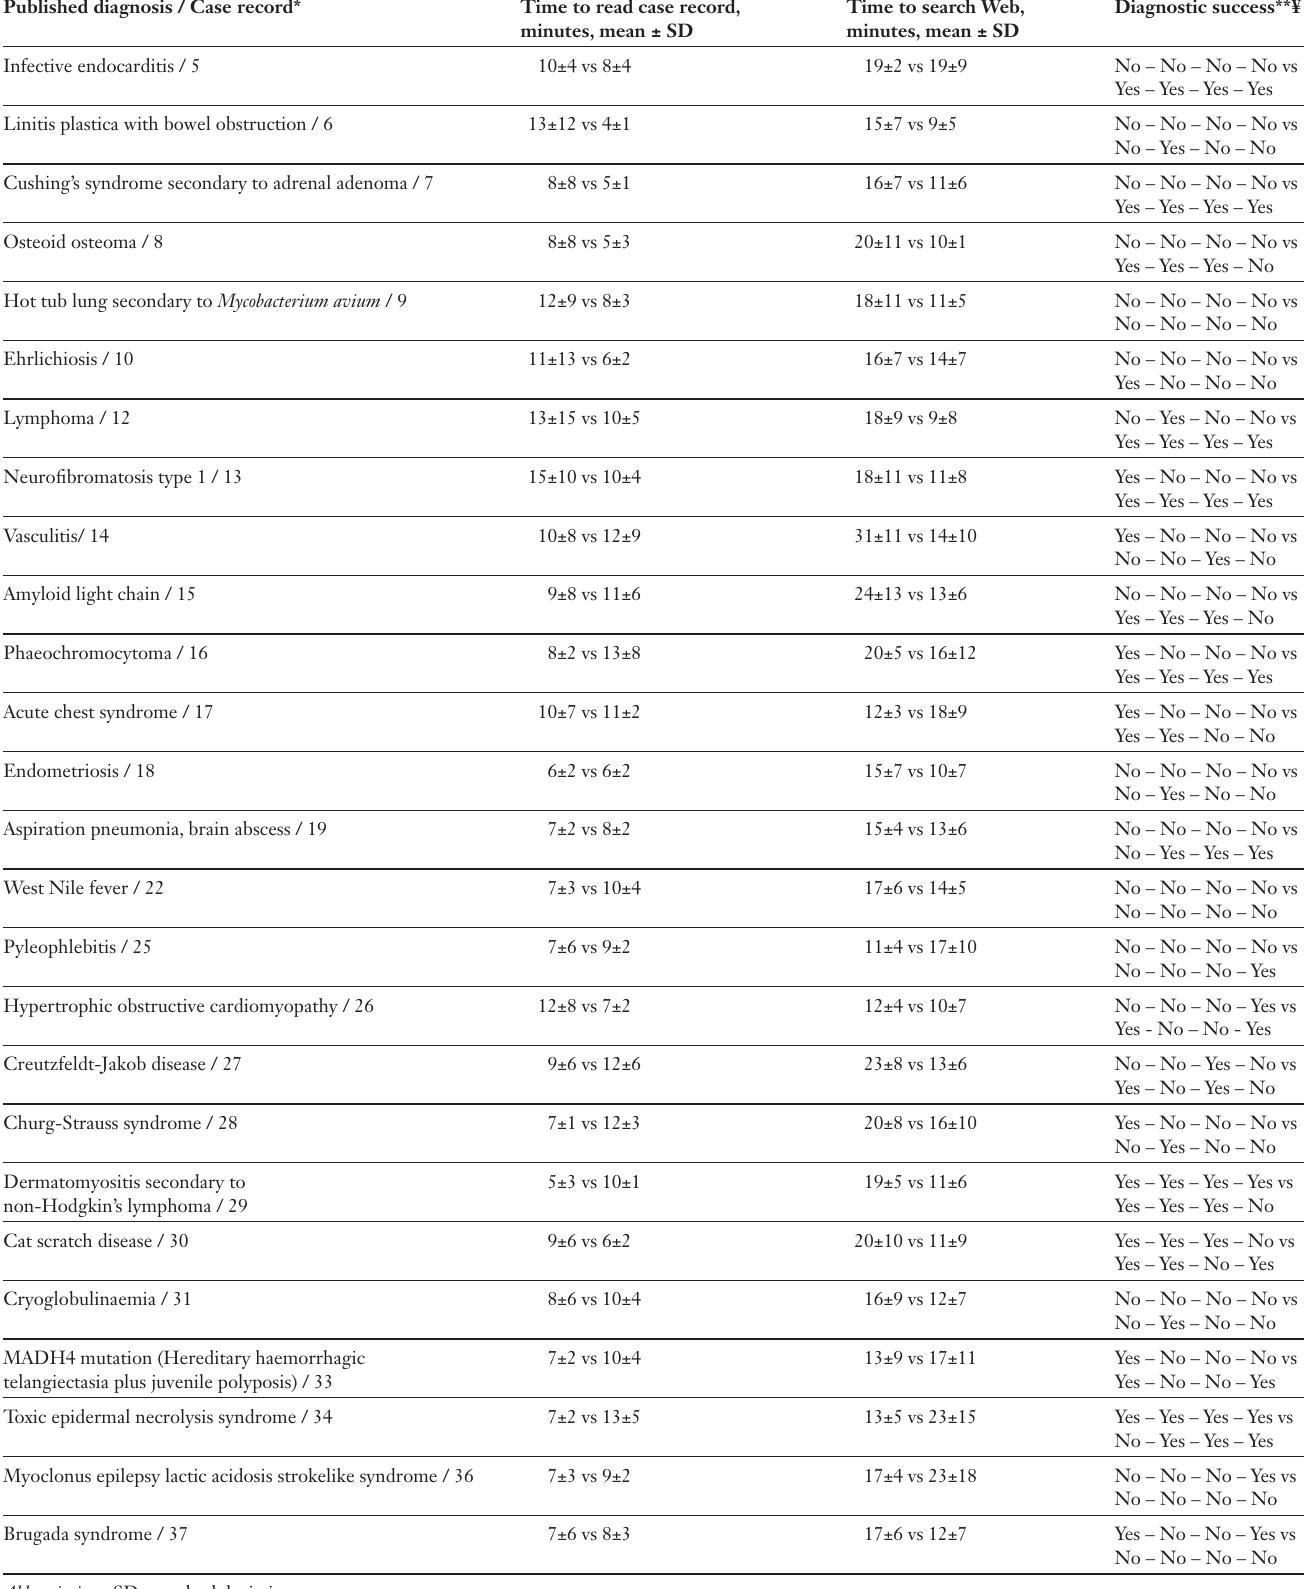
Time required and correct diagnoses arrived at by the Google users participating in the present study (non-physicians vs physicians). Published diagnosis / Case